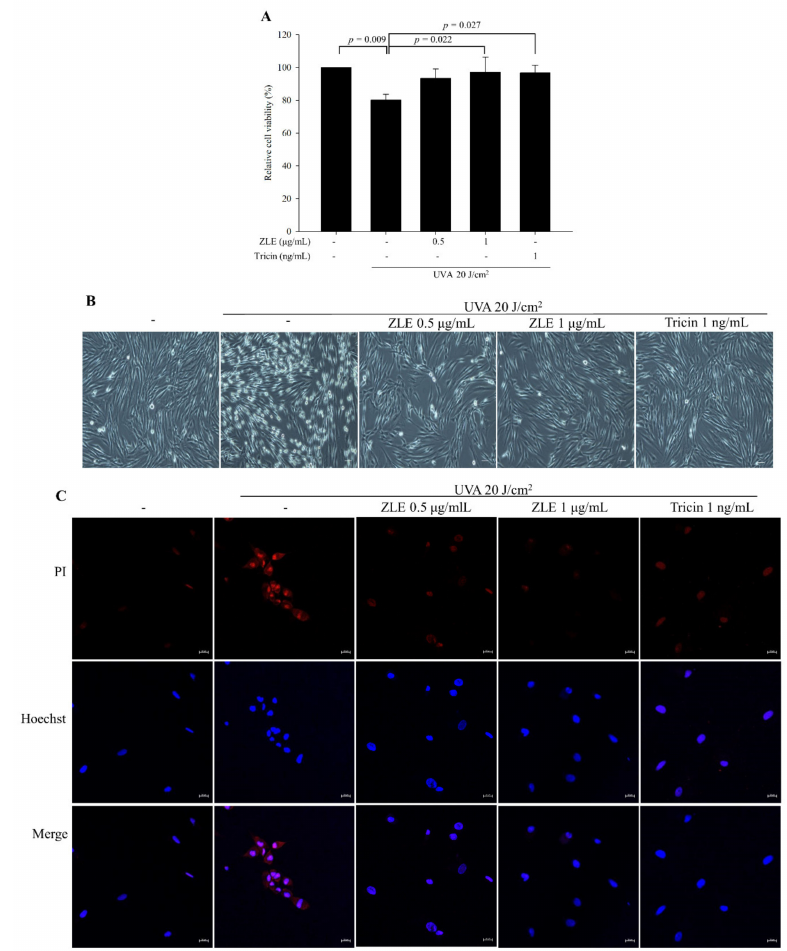
Figure 2. E ff ects of enzyme-treated Z. latifolia extract (ZLE) and tricin on UVA-induced cell viability and plasma membrane disruption in human dermal fibroblasts (HDFs). ZLE and tricin decreased UVA-induced fibroblast cell death and plasma membrane disruption in vitro. A: E ff ect of ZLE and tricin on UVA-induced cell toxicity in